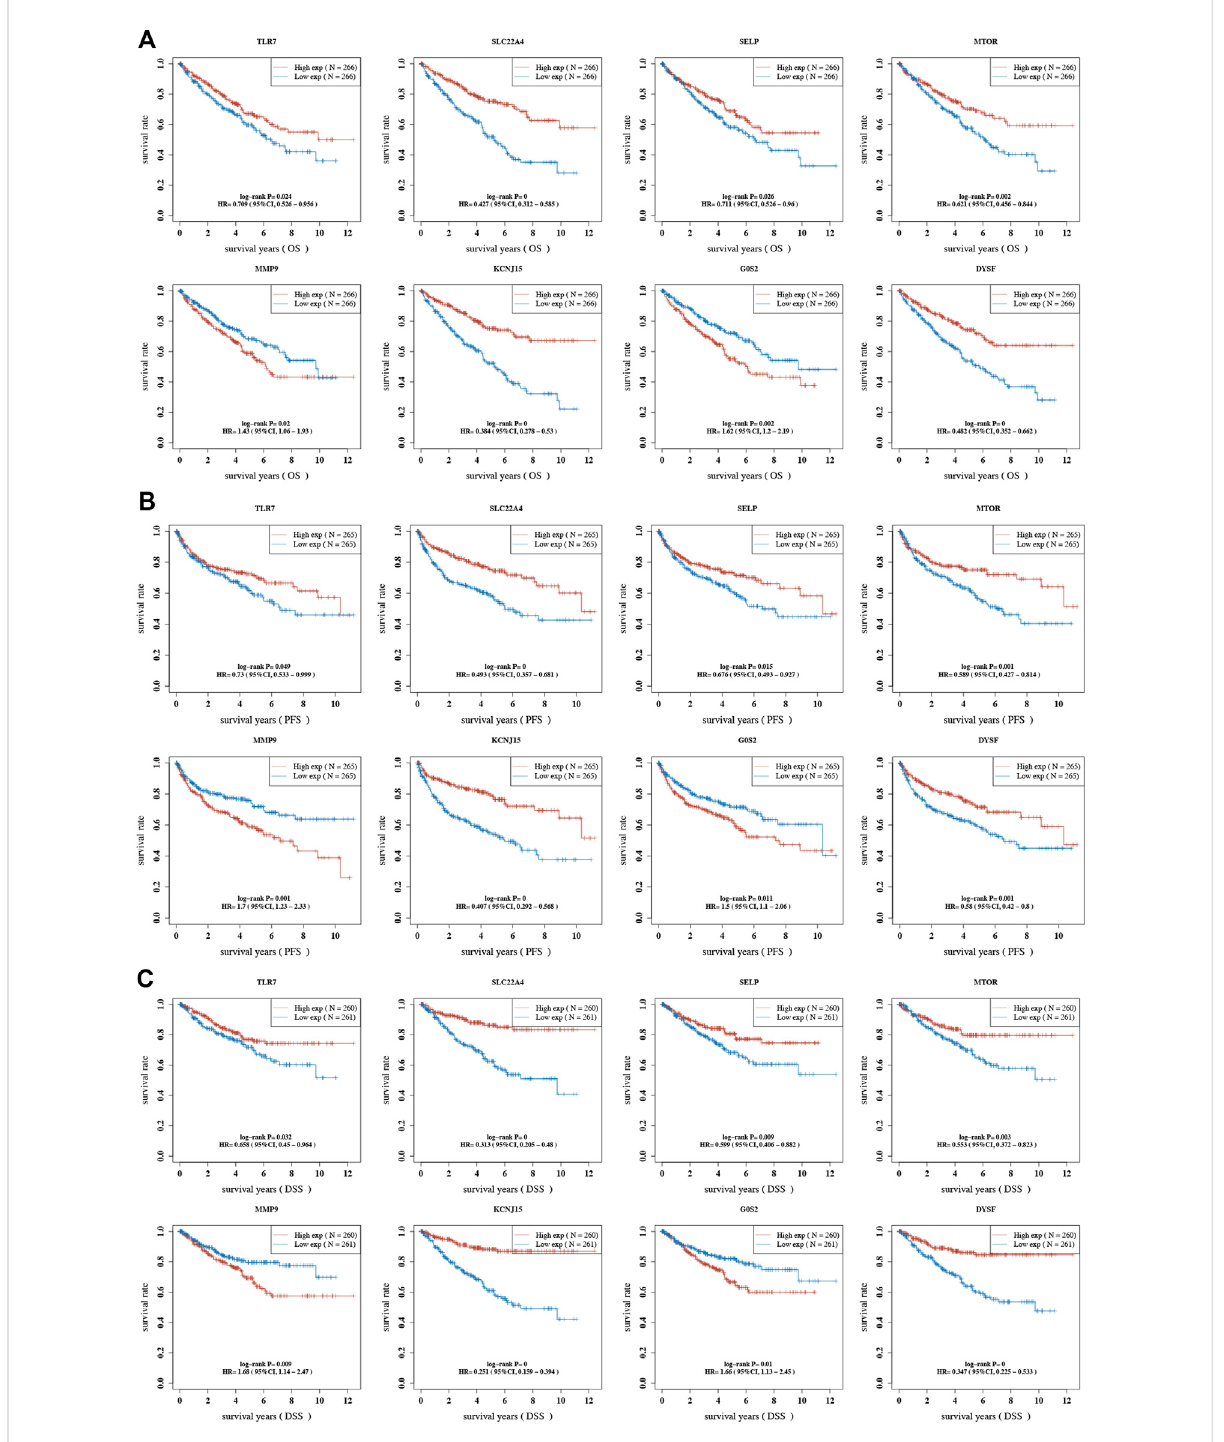
FIGURE 6 Prognostic value of NET-related genes in ccRCC. The Kaplan – Meier curve revealed the result of overall survival (A) , progression-free survival (B) , and disease-speci fi c survival (C) of NET-related genes in ccRCC. NETs, neutrophil extracellular traps; ccRCC, clear cell renal cell carcinoma.